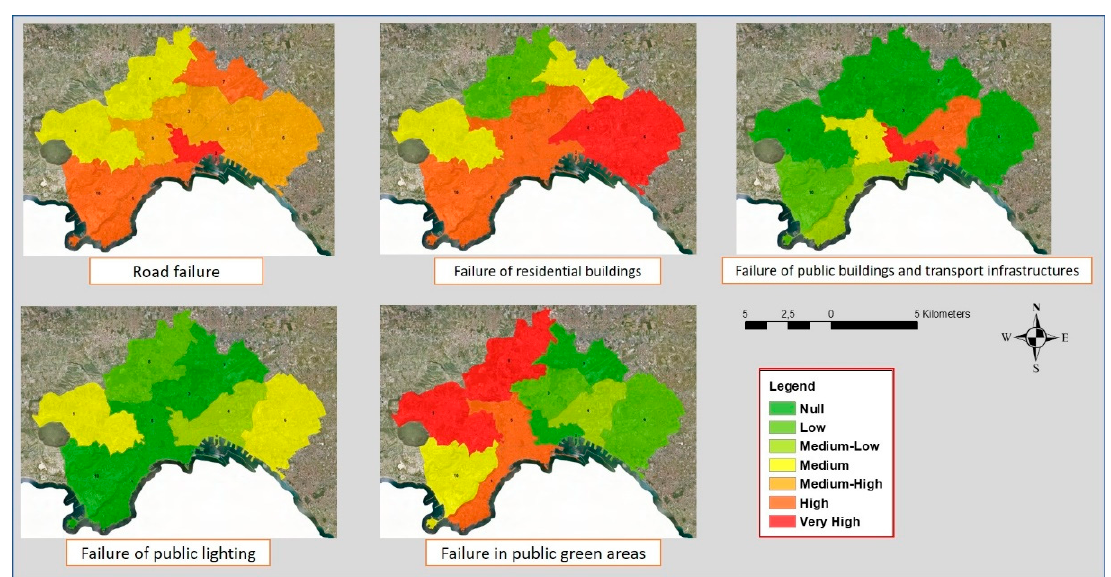
Figure 6. Category thematic maps obtained in the year 2020.